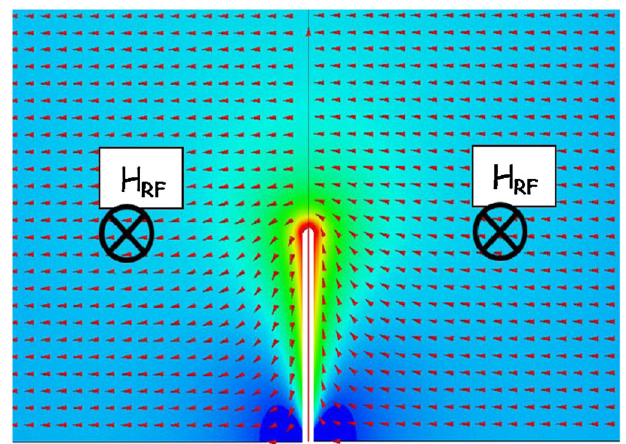
FIG. 8. (Color) The rf power flow distribution near the tip. Arrows show the direction and color code is proportional to the logarithm of the absolute value of associated Poynting vector.